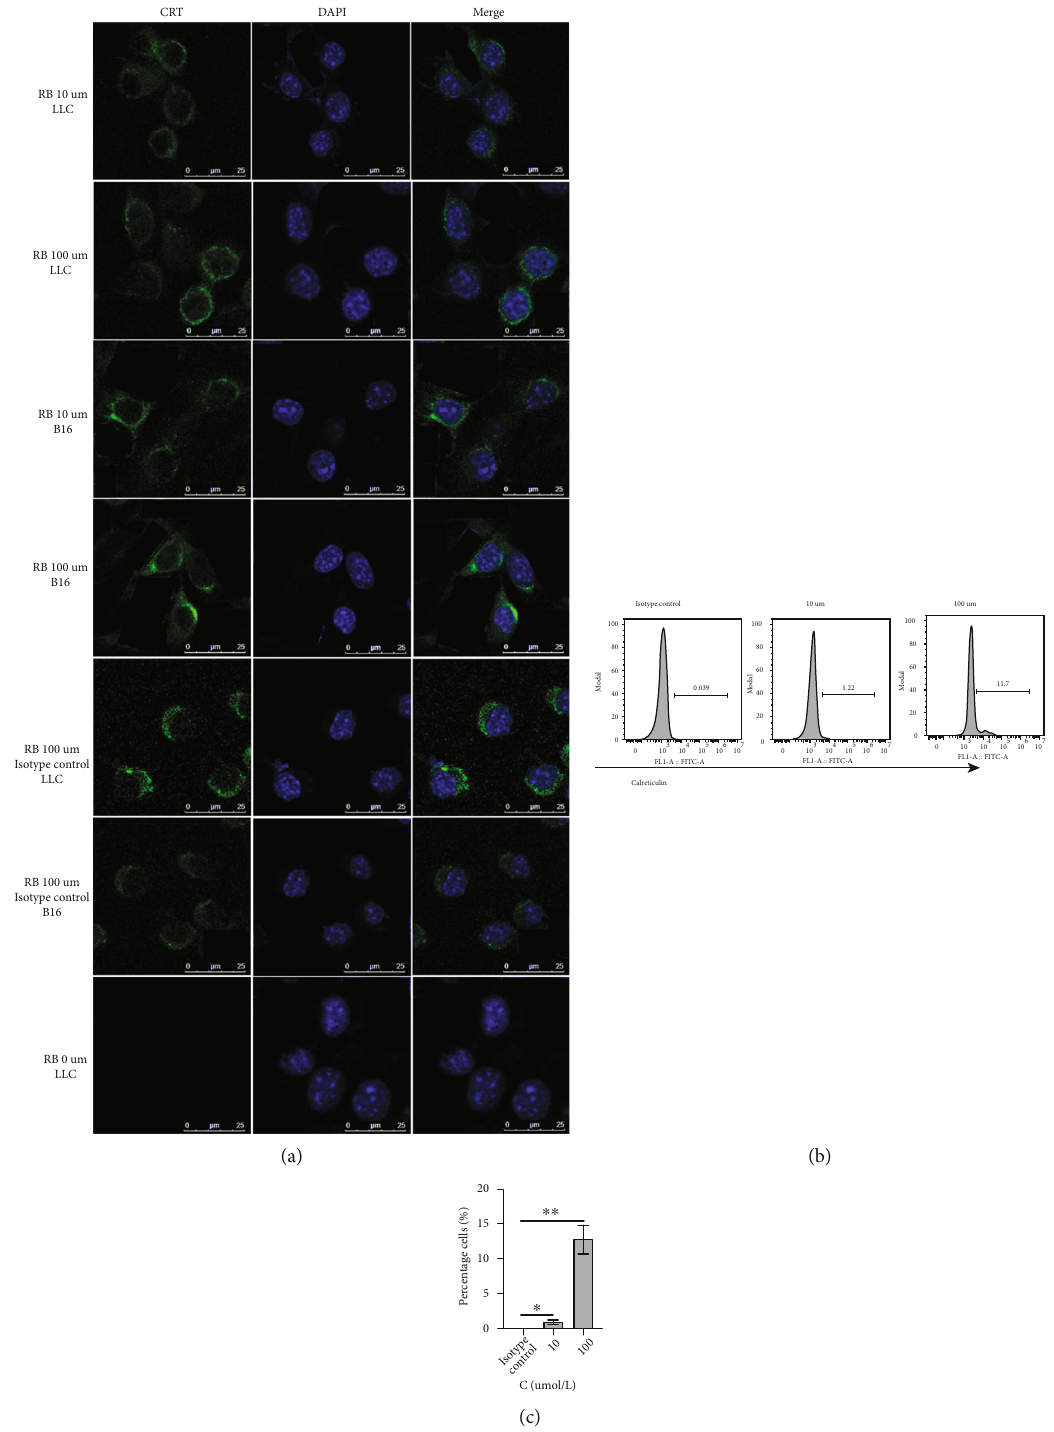
Figure 2: Cancer cells treated with RB were exposed to calreticulin on the surface (ecto-CRT). (a) Immuno fl uorescence analysis of ecto-CRT expression on LLC and B16 cells that were treated with RB (10 or 100 μ M, respectively) for 24 h. (b, c) LLC exhibited increased ecto-CRT expression in a dose-dependent manner after 30min of RB treatment. The gating strategy of ecto-CRT expression of LLCs: First, the cells were collected, and the voltage was adjusted to the blank control. Then, a new scatterplot was created, the target cells were gated (cross gate), and the scatterplot was fi nally compensated by FITC and DAPI single-stained controls. Representative fl ow cytometry data are presented (b) as the mean ± SD from three representative independent experiments (c). The assay was carried out in triplicate and repeated three times. The results are expressed as the mean values ± SD . One-way ANOVA was performed, and the signi fi cance level was de fi ned as ∗ P < 0 : 05 and ∗∗ P < 0 : 01